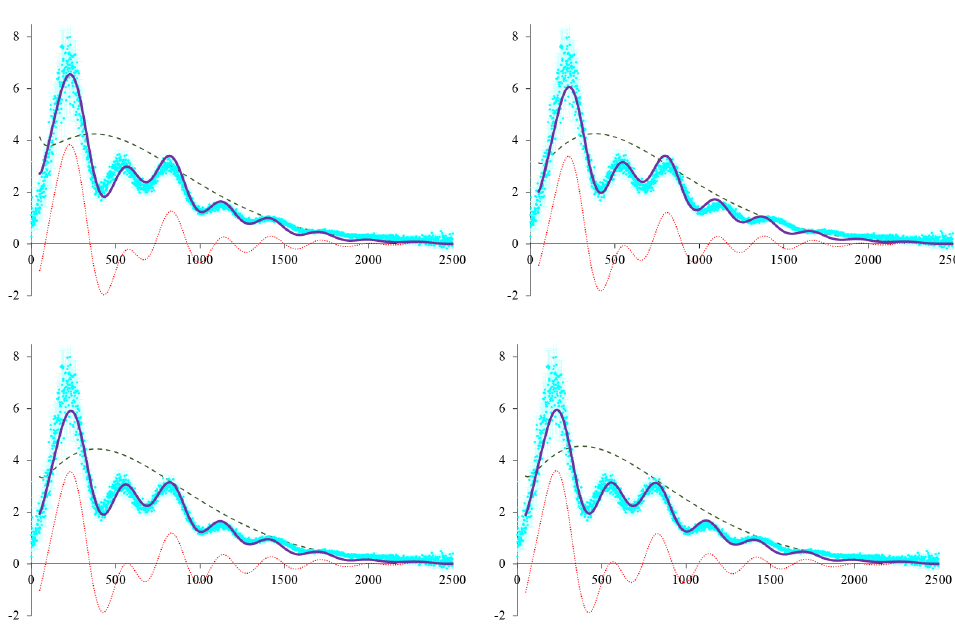
Figure 1. Mukhanov’s approximation of the angular power spectrum in light of Planck 2018 data. Thick blue line: Mukhanov’s approximation as a sum of an oscillatory part (thin dotted red line) and a nonoscillatory part (dashed green line). Planck 2018 data are shown in light blue with vertical error bars. Top row: standard cosmology, with nominal parameters (left) and least squares fitted values for Ω Ω b and n s (right). Bottom row: The MOG theory, with b , α and n s fitted (left) and with the same 3-parameter fit but setting H 0 = 73 km/s/Mpc fitted